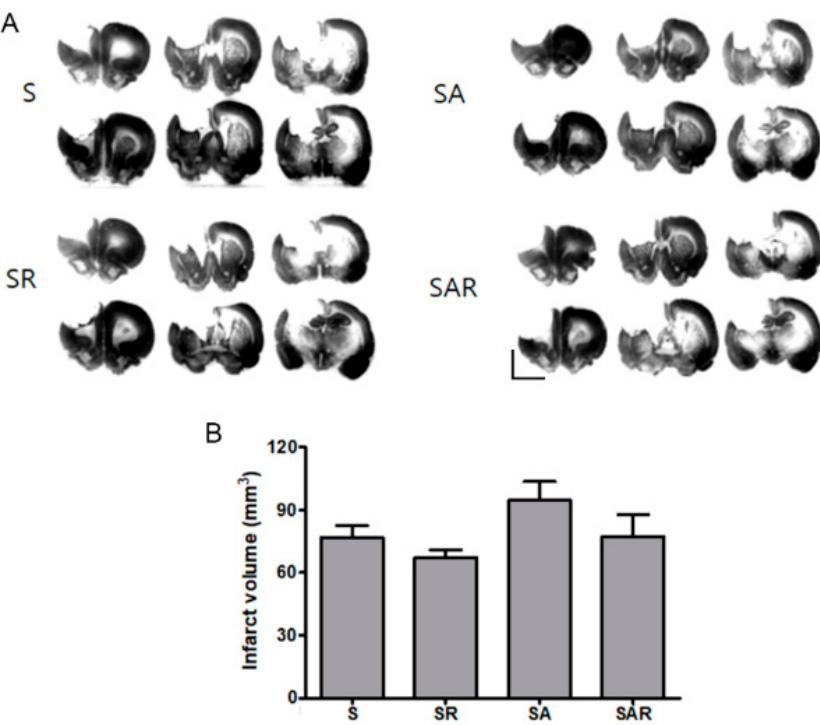
Figure 4. Effects of TST and 5-Aza-dC treatment on infarct volume after photothrombic ischemic stroke ( A ) Representative photomicrography of Nissl-stained sections four weeks after post-stroke treatment; ( B ) Quantification of infarction size did not differ in treatment groups after photothrombic ischemic stroke. Results are presented as the mean ± SEM, n = 6. Scale bars = 5 mm. 2.4. 5-Aza-dC Combined with TST Treatment Improved the Recovery of Motor Function on the Chronic